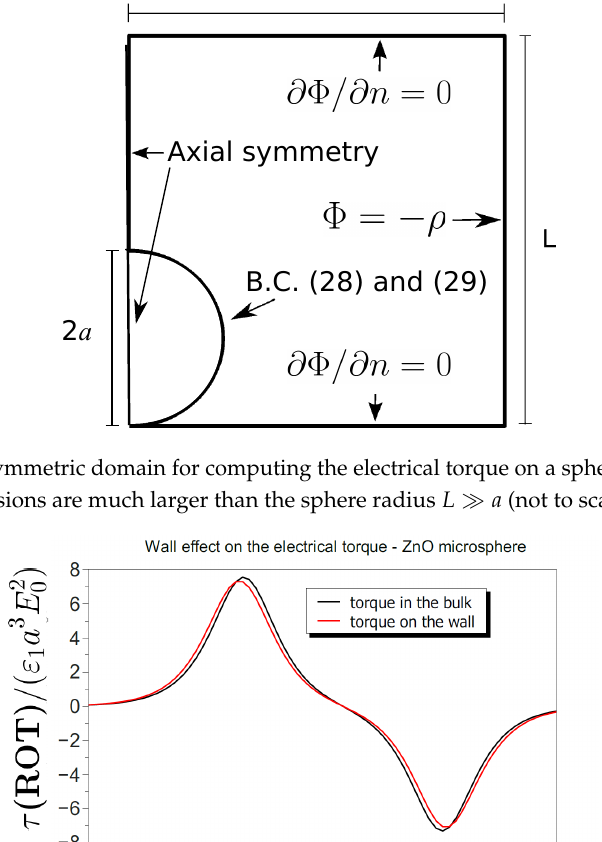
) as a function of frequency exerted by a 0